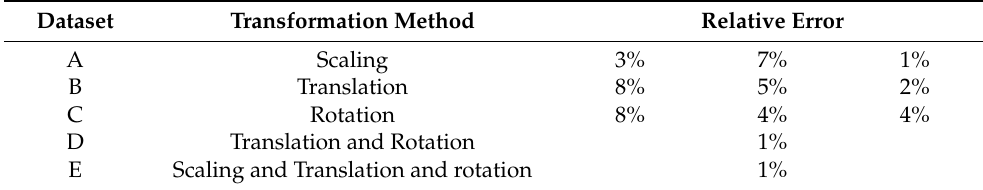
Table 2. Relative error of image registration.